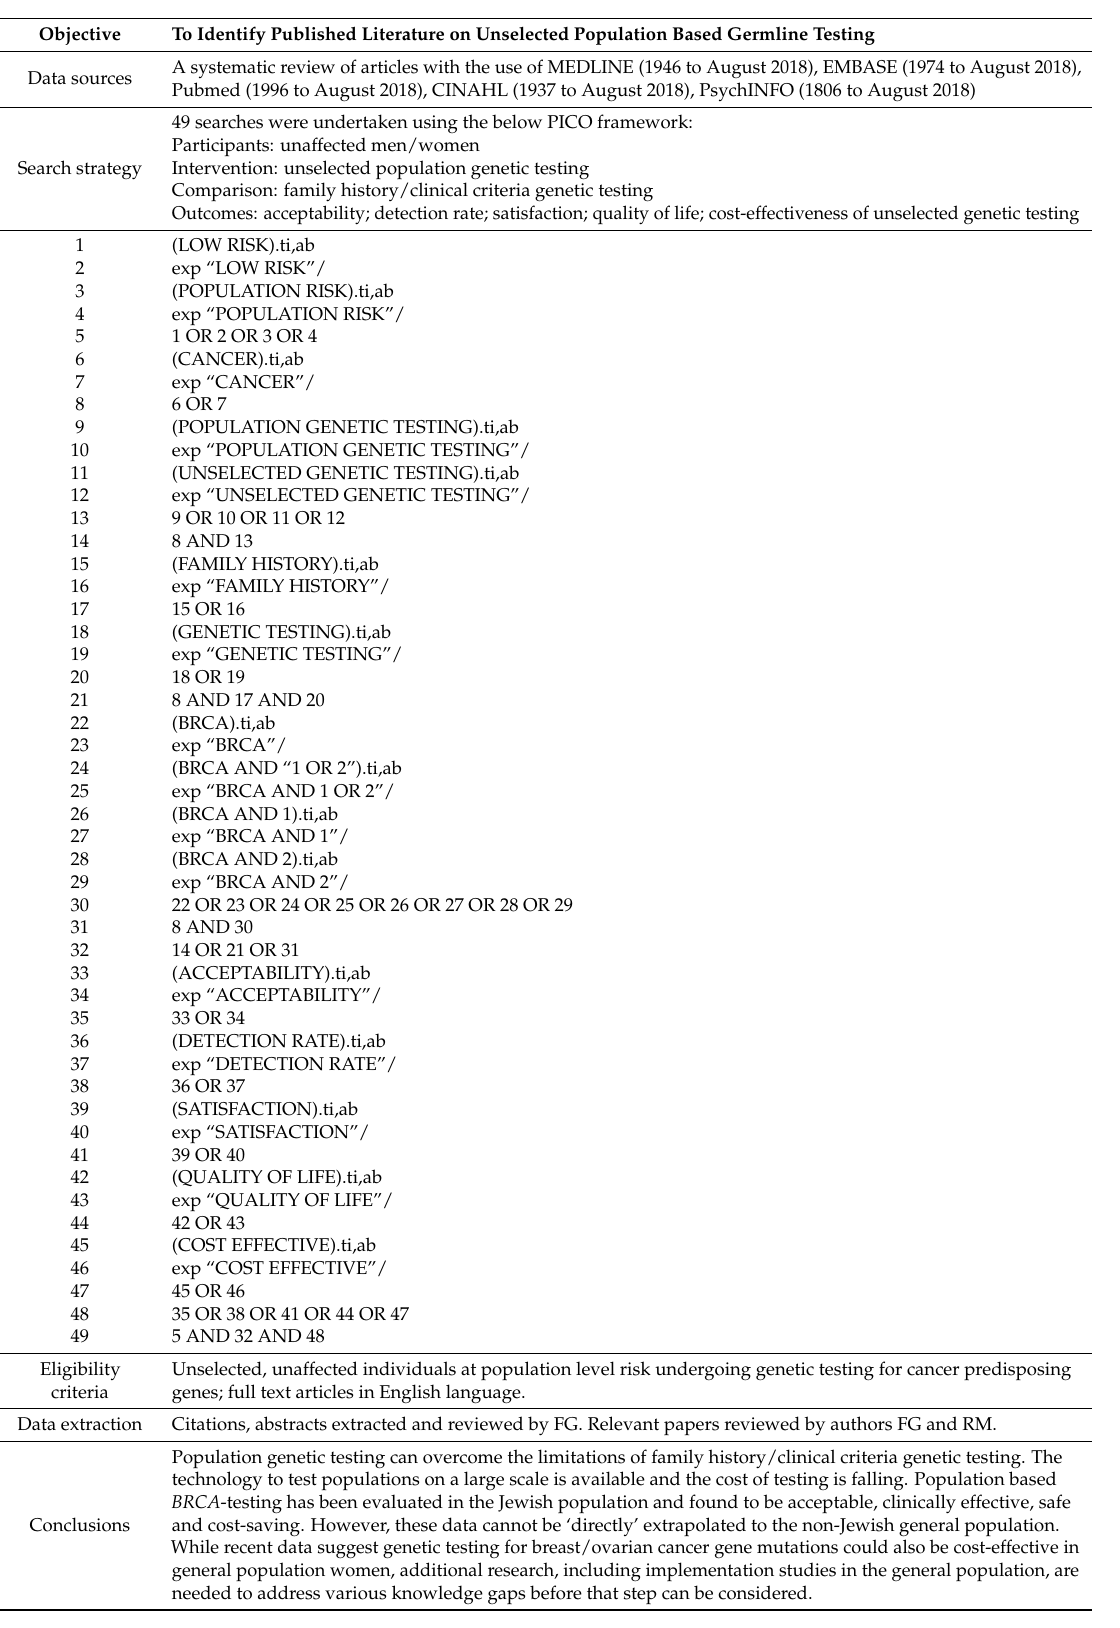
Table 1. Search strategy for literature